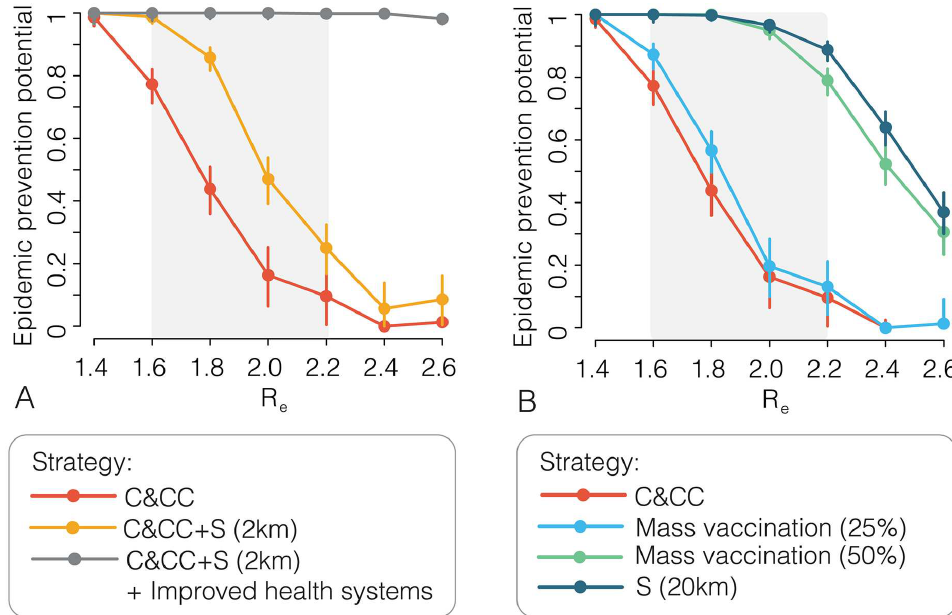
Fig 3. A Estimated epidemicpreventionpotential and 95%CI for a range of R e values using three ring-defining strategies: contacts and contacts of contacts (C&CC) of index cases; C&CC with a spatial ring of radius 2km around index cases (C&CC+S); C&CC+S (2km) plus “improved health systems”, which includesreducing time to isolationof cases (2–3 days from onset to hospitalisation), increasing ring vaccinationcoverageto 90% of eligibleindividuals, and reducing public access to infected areas. The shaded grey area denotes the most plausible R e values for the 2014–15epidemicin West Africa. B As A but consideringmass vaccination (coverage 25% and 50%) and a spatial ring (S) of 20km around index cases. Each estimate is based on 1,000 simulated